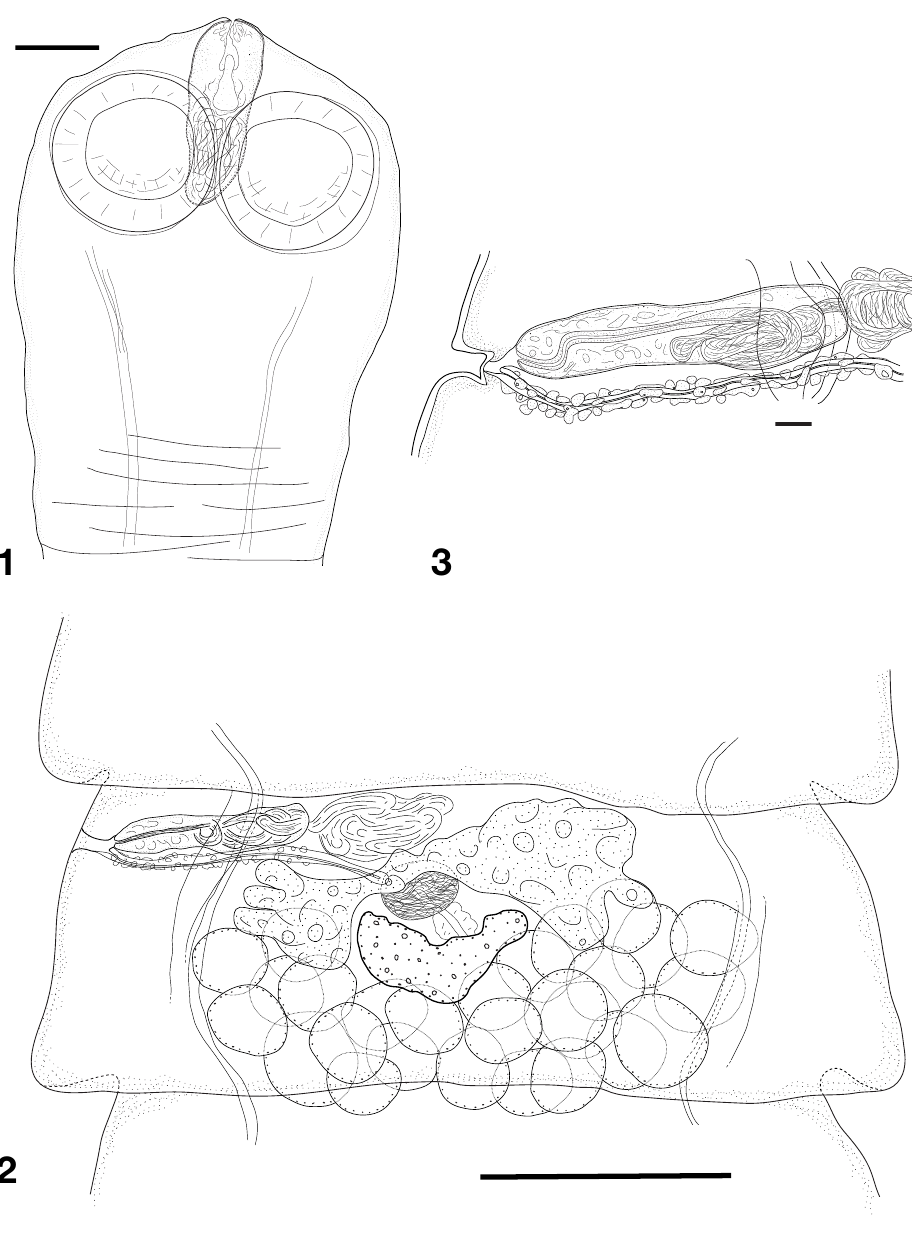
Figs 1–3. Emberizotaenia aeschlii sp. nov. 1 . Scolex. 2 . Mature proglottis, ventral view. 3 . Cirrus-sac. Figs 1-3. Emberizotaenia aeschlii sp. nov. 1 . Scolex; 2 . Mature proglottis, ventral view; 3 . Cirrus- Scale bars: 1 = 100 µm; 2 = 250 µm; 3 = 20 sac. Scale bars: 1 = 100µm; 2 = 250µm; 3 = 20 µm.